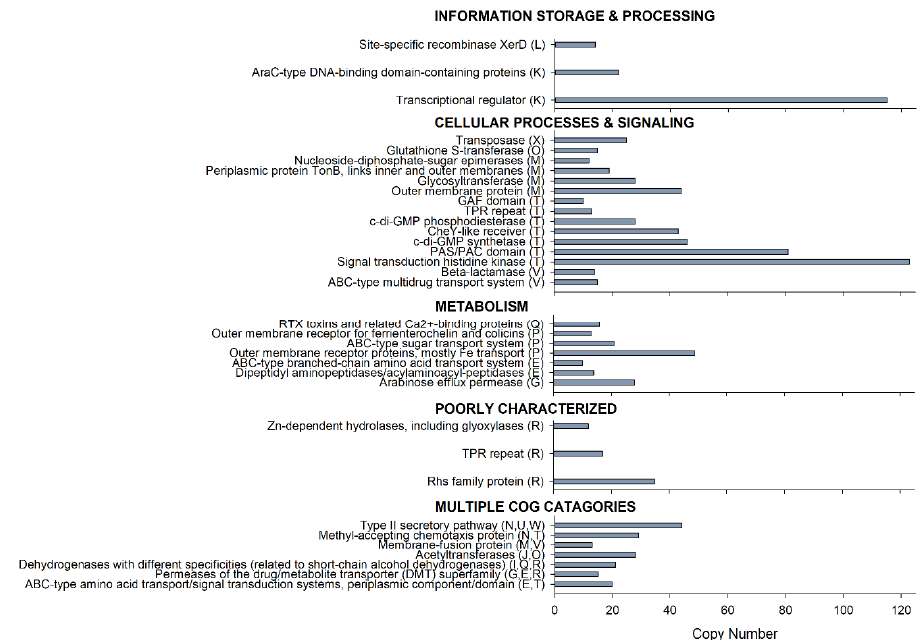
Figure 4. Janthinobacterium sp. CG23_2 species-specific clusters of orthologous groups (COGs). Only COGs with n ≥10 copy numbers are shown.